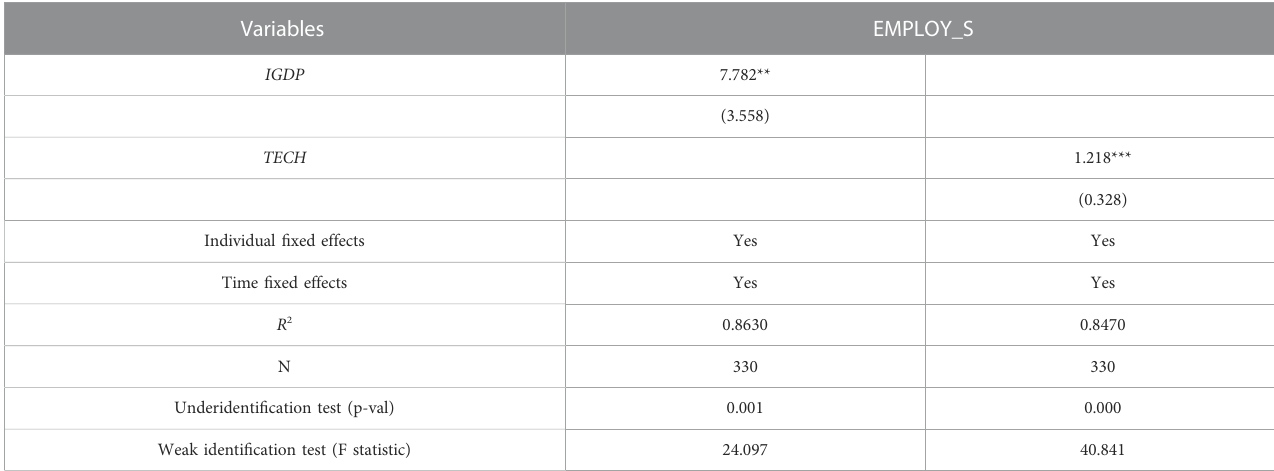
TABLE 8 Robustness test results